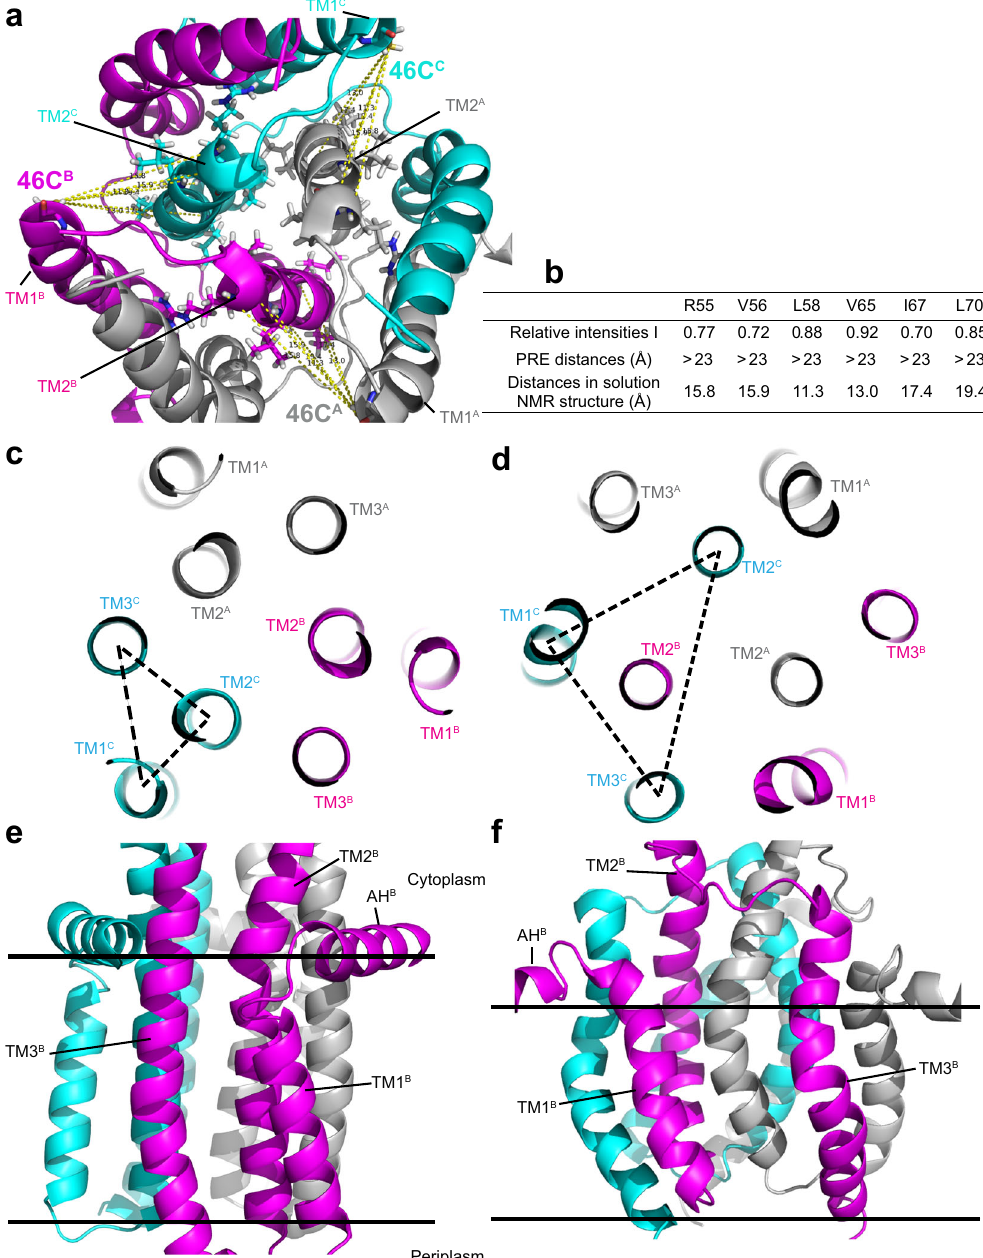
Fig. 7 Comparison of the ssNMR DgkA structure reconstituted in E. coli membrane total extracts with the one in DPC micelles determined by solution NMR (PDB#: 2KDC). a The inter-monomer distance measurements between 46C and residues R55, V56, L58, V65, I67, and L70 in the solution NMR structure (with domain swapping). b Comparison of distances from inter-monomer PRE data of the undiluted 46C sample, with those from the solution NMR structure. ssNMR structure of DgkA viewed from the cytoplasm ( c ) and membrane plane ( e ). Solution NMR structure of DgkA viewed from cytoplasm ( d ) and membrane ( f ) planes. Monomers A, B, and C are colored in gray, magenta, and cyan, respectively. In panels ( c and d ), TM1, TM2, and TM3 helices of monomer C are connected with a dashed triangle to highlight the differences in monomer packing pattern in the ssNMR and solution NMR DgkA structures. The hydrophobic regions of the ssNMR structure in ( e ) and solution NMR structure in ( f ) were identi fi ed based on the analysis of H/D exchange data 24 and 19 F NMR data 61 ,